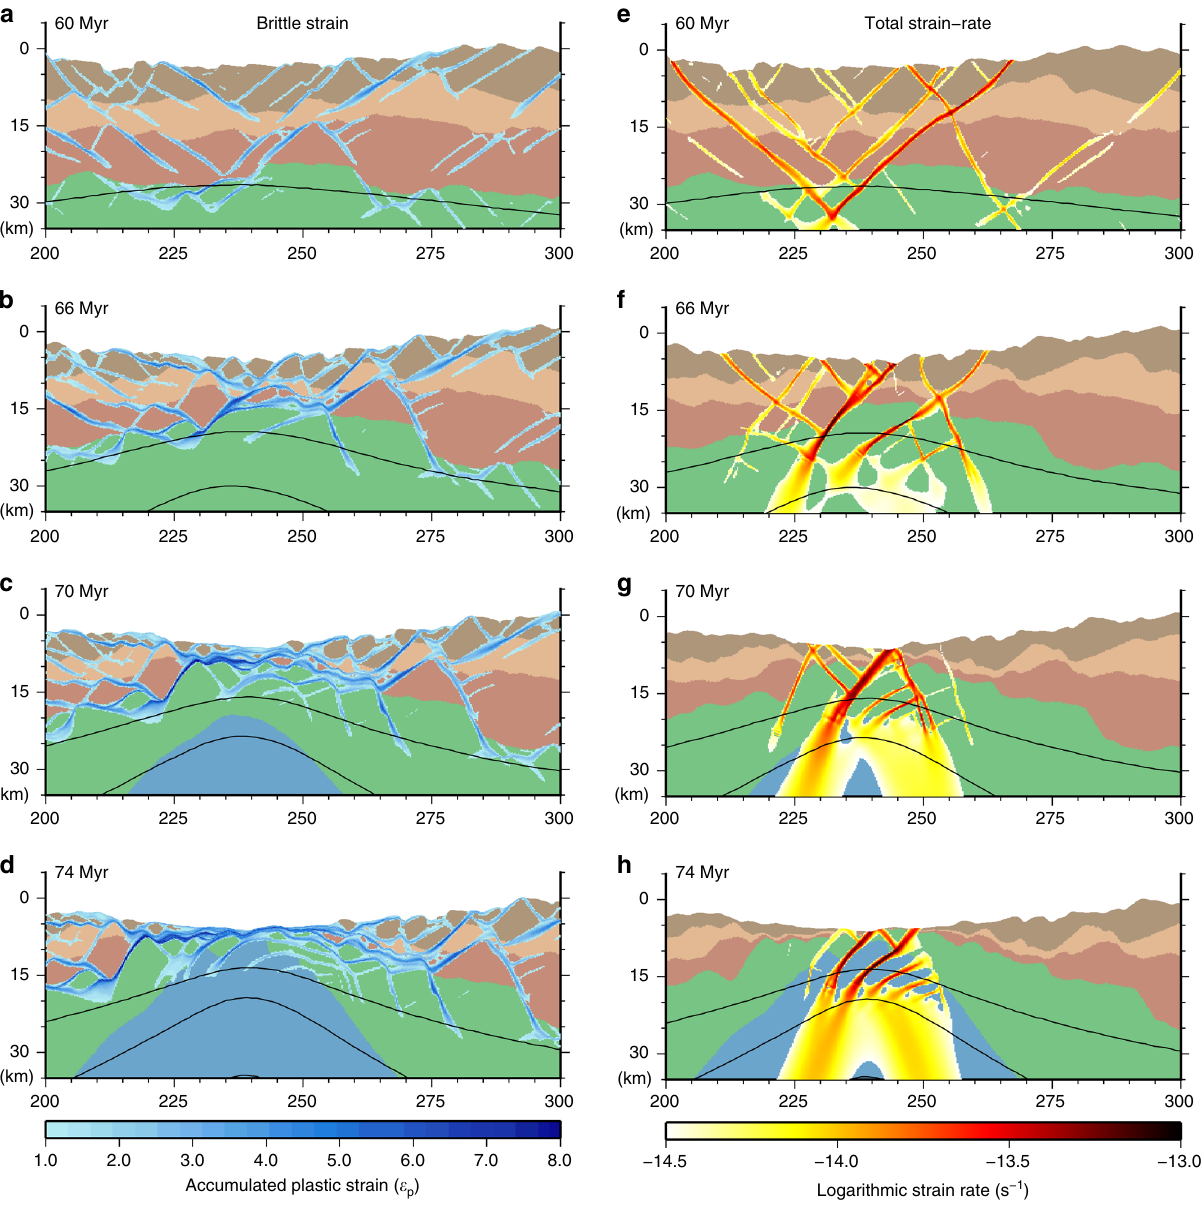
Fig. 3 Evolution of fi nite strain and active deformation. Detailed evolution of the transition from stretching to hyperextension and exhumation in the numerical experiments. Each panel contains the compositional fi elds with accumulated plastic (brittle) strain a – d or logarithmic strain-rate e – h superimposed. As extension proceeds, high-angle faults formed in the early stretching phase are rotated sub-horizontally and stretched, while active